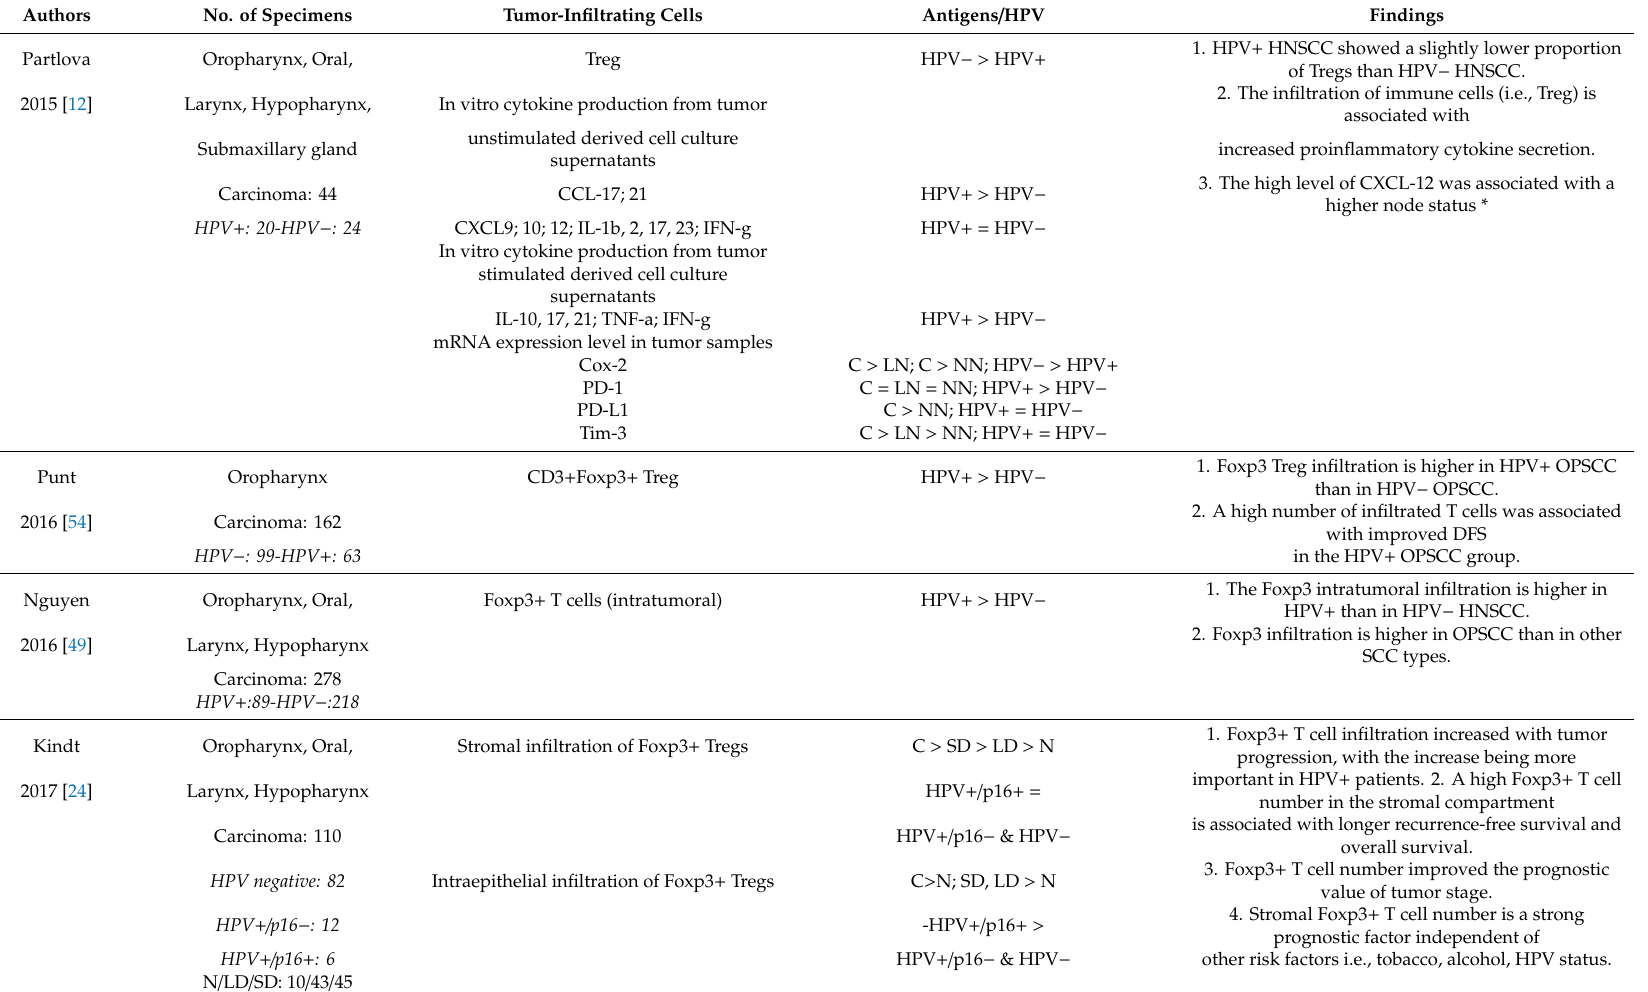
Table 4. Foxp3 T regulatory cell infiltration in HPV + and HPV − head & neck squamous cell